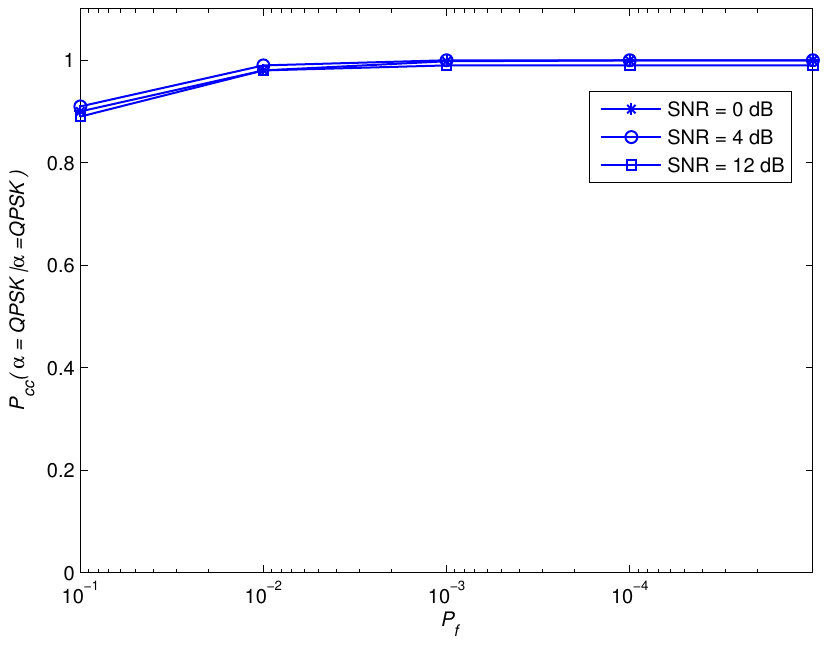
Figure 12. Pcc ( α = QPSK | α = QPSK ) for the modulation group of θ 1 .